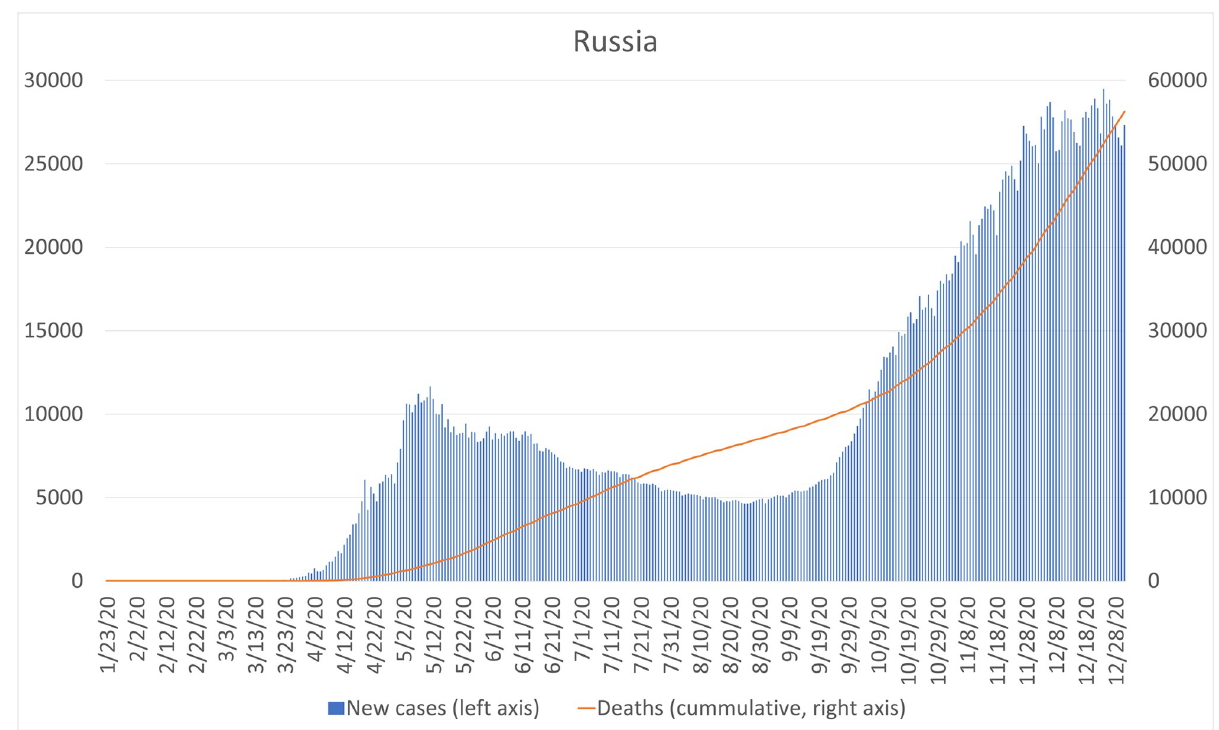
Fig 2. Number of newly confirmed cases and deaths in Russia. Source: Novel Coronavirus (COVID-19) Case Data https://data.humdata.org/dataset/ novel-coronavirus-2019-ncov-cases.